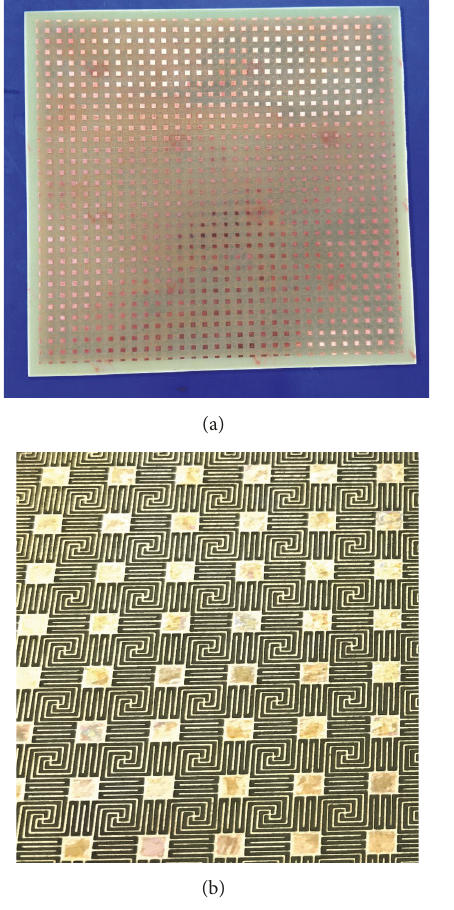
Figure 4: Photograph of the fabricated prototype. (a) FSS and (b) FSS zoom view.